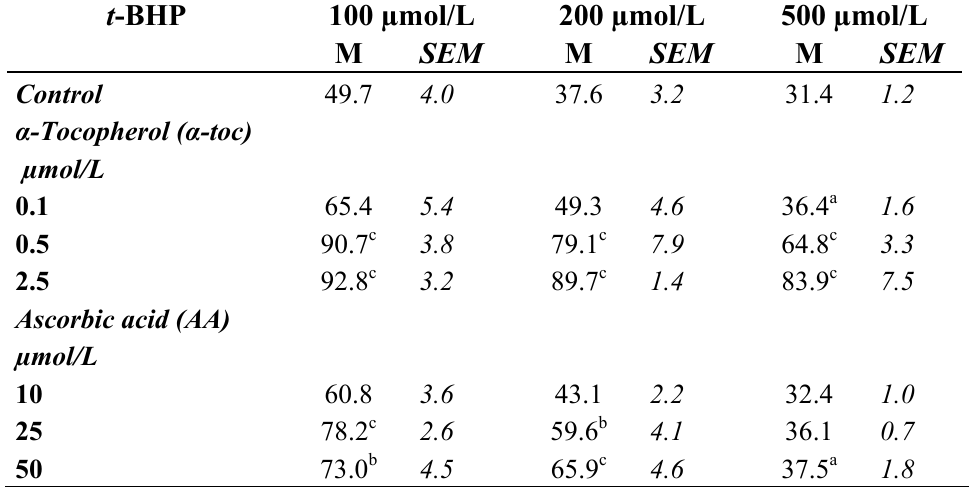
Table 1. Effect of α -tocopherol, ascorbic acid and selenium on cell viability after challenge with increasing concentrations of t -BHP. Data are means ± SEM and expressed in percentage of untreated control